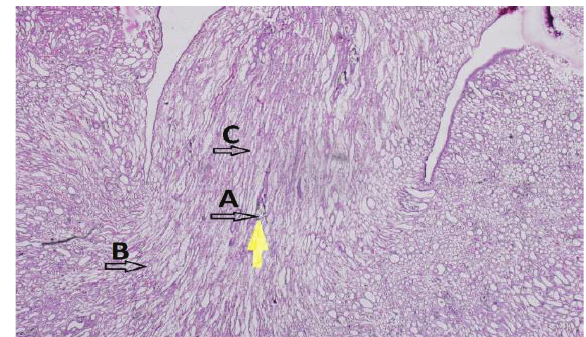
Fig-3: Histopathology of kidney(rat) received allopurinol (group 3) under 4x showing few crystals in few dilated tubules A. less no of crystals in few tubules B. Intact cortex and medulla junction C. Intact